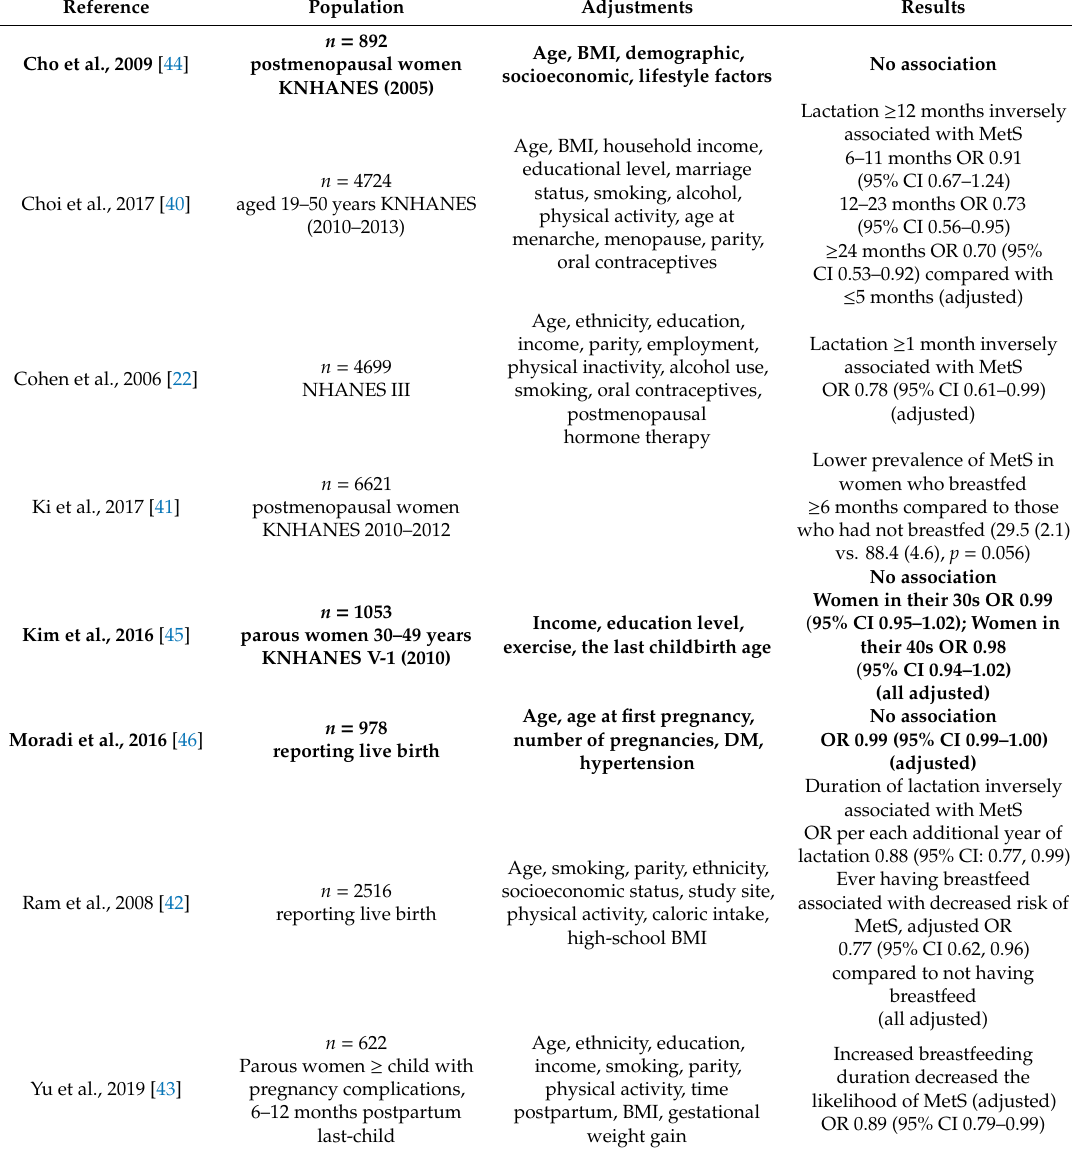
Table 3. Cross-sectional studies on breastfeeding and metabolic syndrome